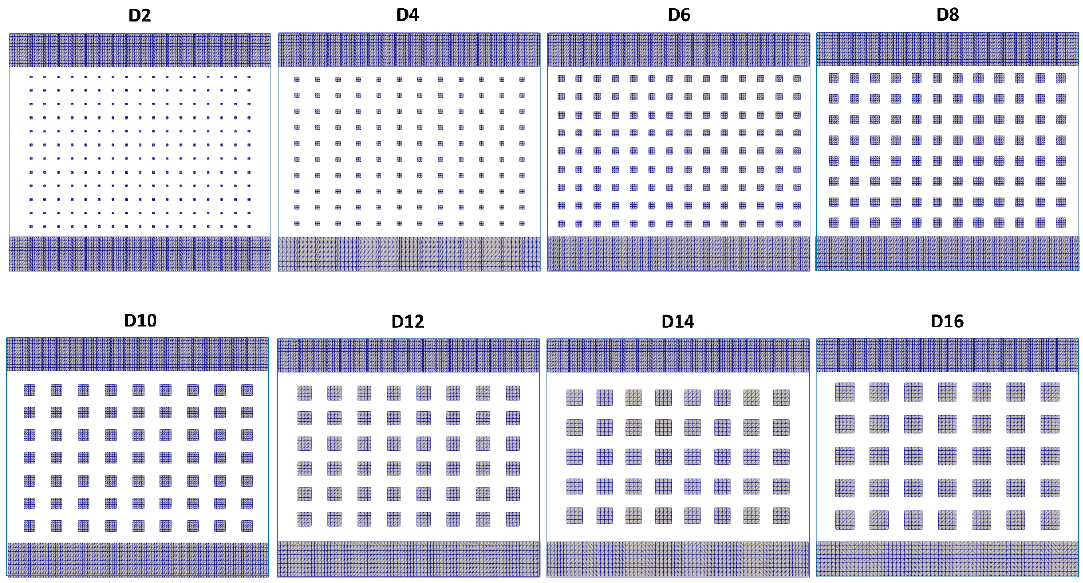
ffl e for each of the six designs analyzed. Figure 3. Hole distribution on the baffle for each of the six designs analyzed. Figure 3. Hole distribution on the ba Table 1. Perforation parameters of ba ffl e